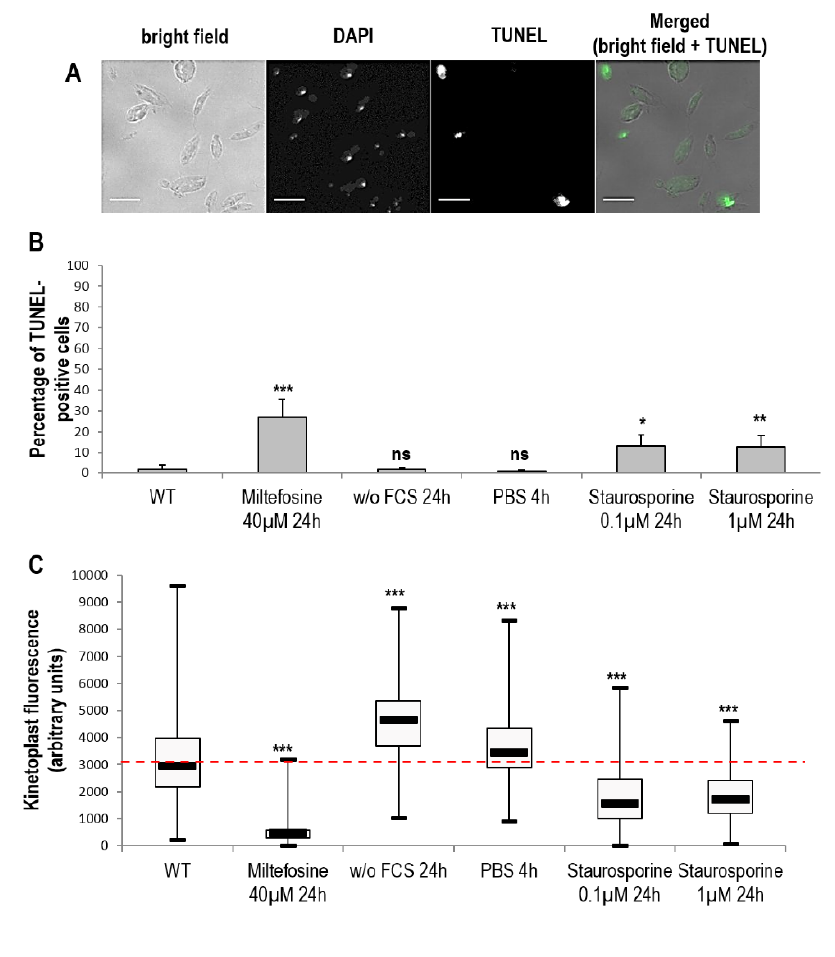
FIGURE 4: DNA degradation during